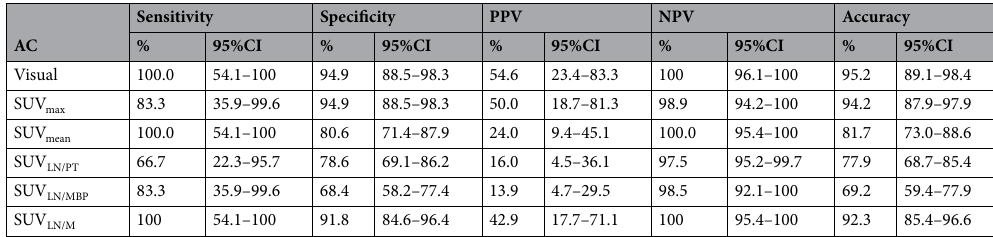
Table 4. Diagnostic performances of the SUV parameters at 18 F-Alfatide PET/CT in patients with AC. AC,